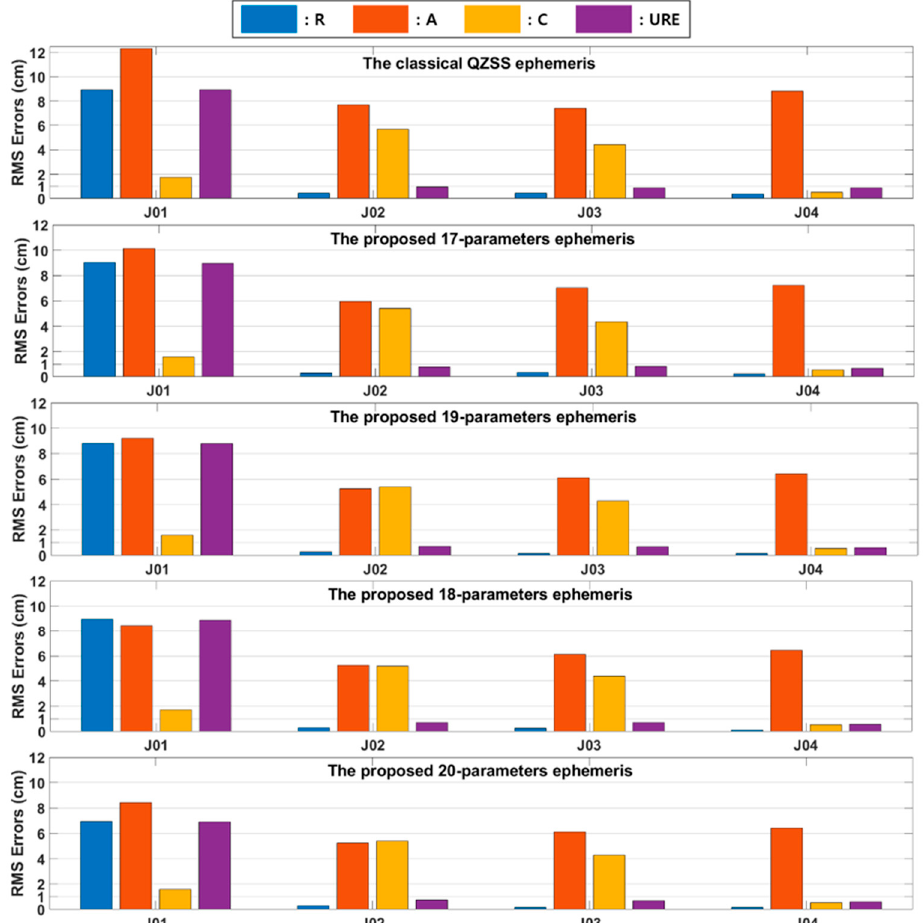
Figure 5. RMS errors in RTN components and UREs with different parameter sets for QZSS.